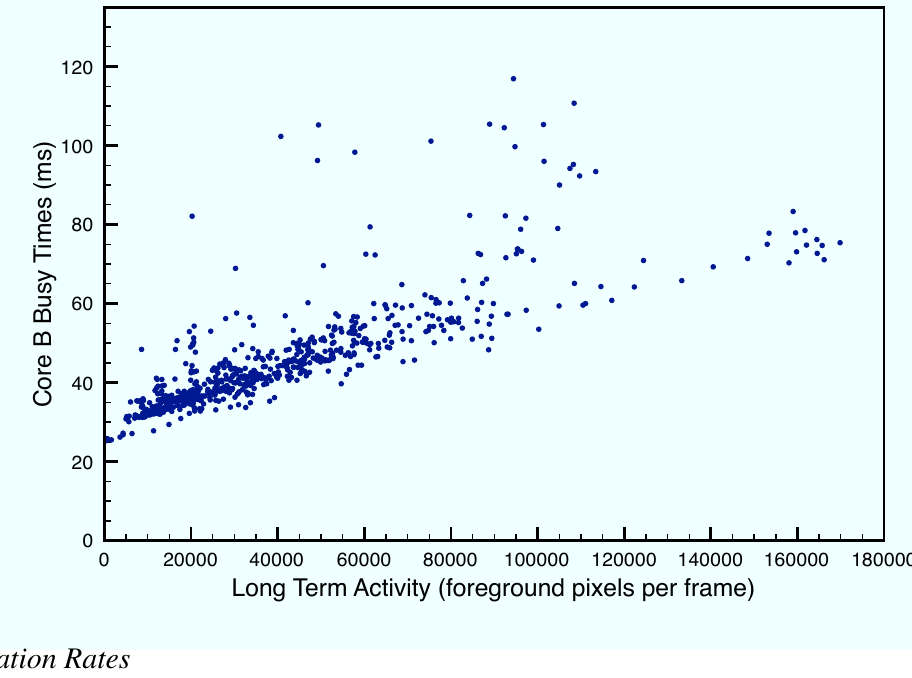
Figure 13. Measured processing times of the Core B as a function of the Long Term Activity (number of foreground pixels) of each frame, during a real sequence with 750 consecutive frames.